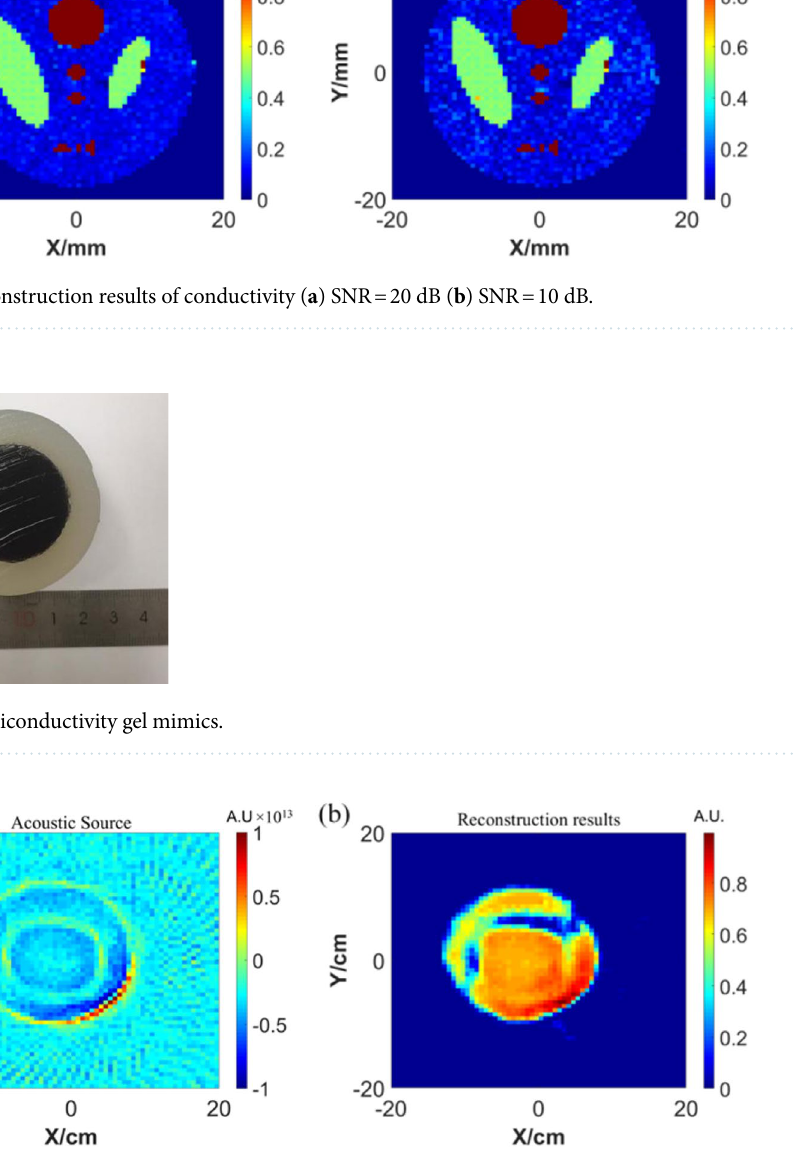
Figure 16. ( a ) Reconstruction of the acoustic source by the FBP ( b ) reconstructed conductivity results of GAN